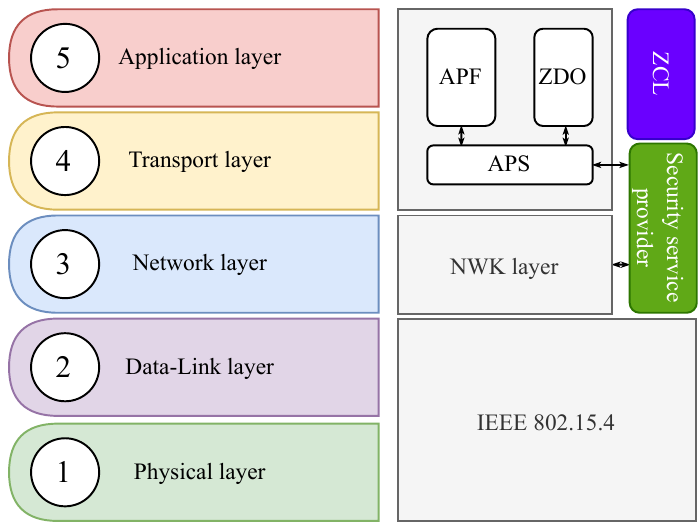
Figure 4. Comparing ZigBee stack with OSI